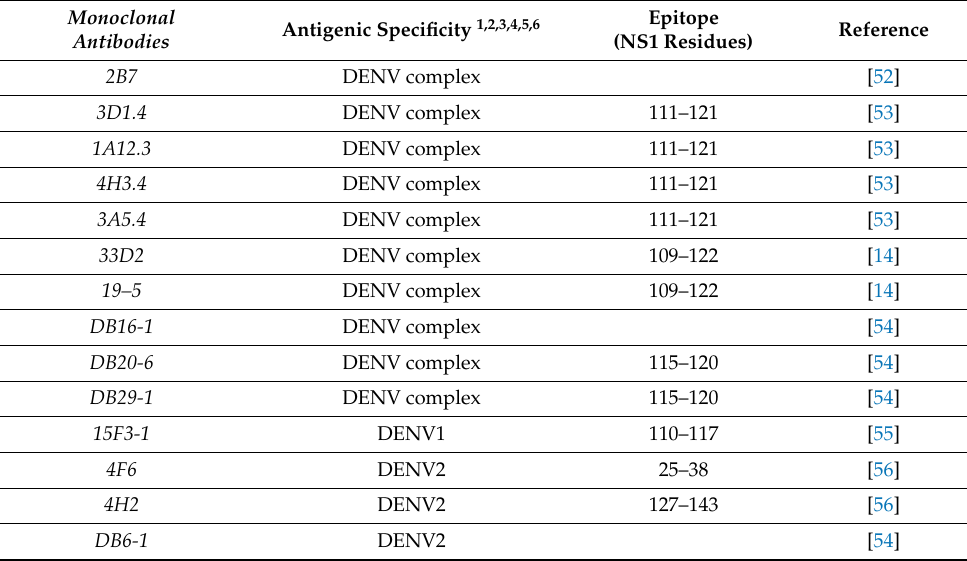
Table 1. List of anti-NS1 monoclonal antibodies, their virus specificity, and recognized epitopes, if